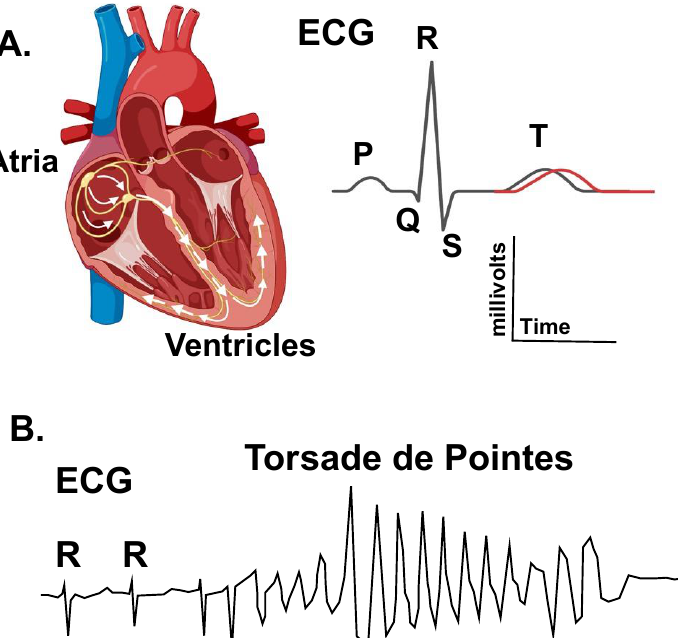
Figure 1. Long-QT syndrome (LQTS) is an arrhythmia disorder that sometimes causes a prolongation in the QT interval as measured on an electrocardiogram (ECG). ( A ). The left diagram shows a cross section of the heart illustrating the cardiac conduction pathway in the atrial and ventricles. The electrical activation of the heart (arrows) is measured using electrocardiography. The right image shows an ECG trace for a single cardiac cycle. The depolarization of the atria generates the P-wave, the depolarization of the ventricle generates the QRS complex, and the repolarization of the ventricle generates the T-wave. The QT-interval changes as a function of the heart rate (as measured by the RR-interval). ( A ) Prolongation in the heart rate-corrected QT-interval is a biomarker for an increased risk of polymorphic ventricular tachycardia Torsade de pointes. ( B ). Diagram of an ECG trace showing a typical Torsade de pointes arrhythmia. Torsade results in a loss in cardiac output and can cause syncope, seizures, and sudden cardiac death.